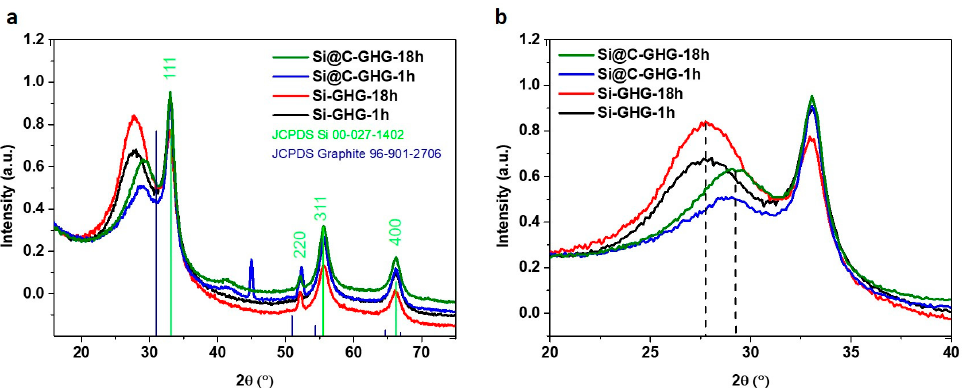
Figure 4 . XRD di ff ractograms of Si-GHG-1h, Si-GHG-18h, Si@C-GHG-1h, and Si@C-GHG-18h ( a ) Figure 4. XRD diffractograms of Si-GHG-1h, Si-GHG-18h, Si@C-GHG-1h, and Si@C-GHG-18h with a zoom on the graphitic peaks ( b ) . ( a ) with a zoom on the graphitic peaks ( b